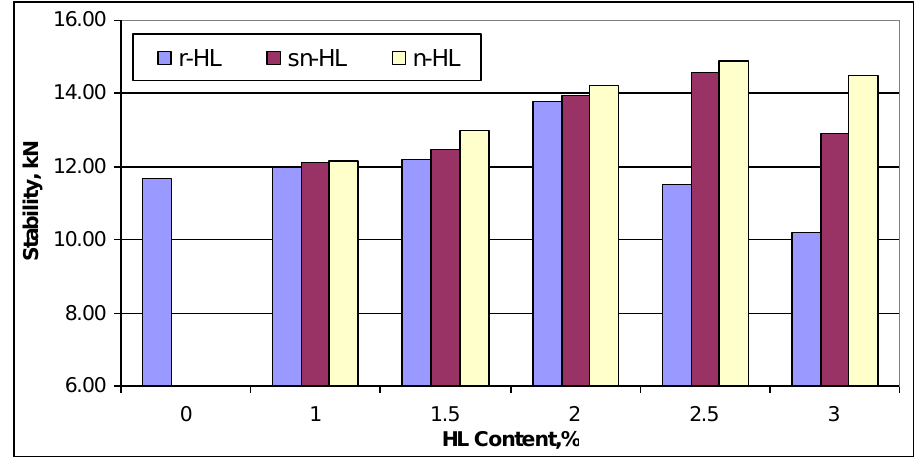
Figure 7. Marshall stability vs. HL type and content.